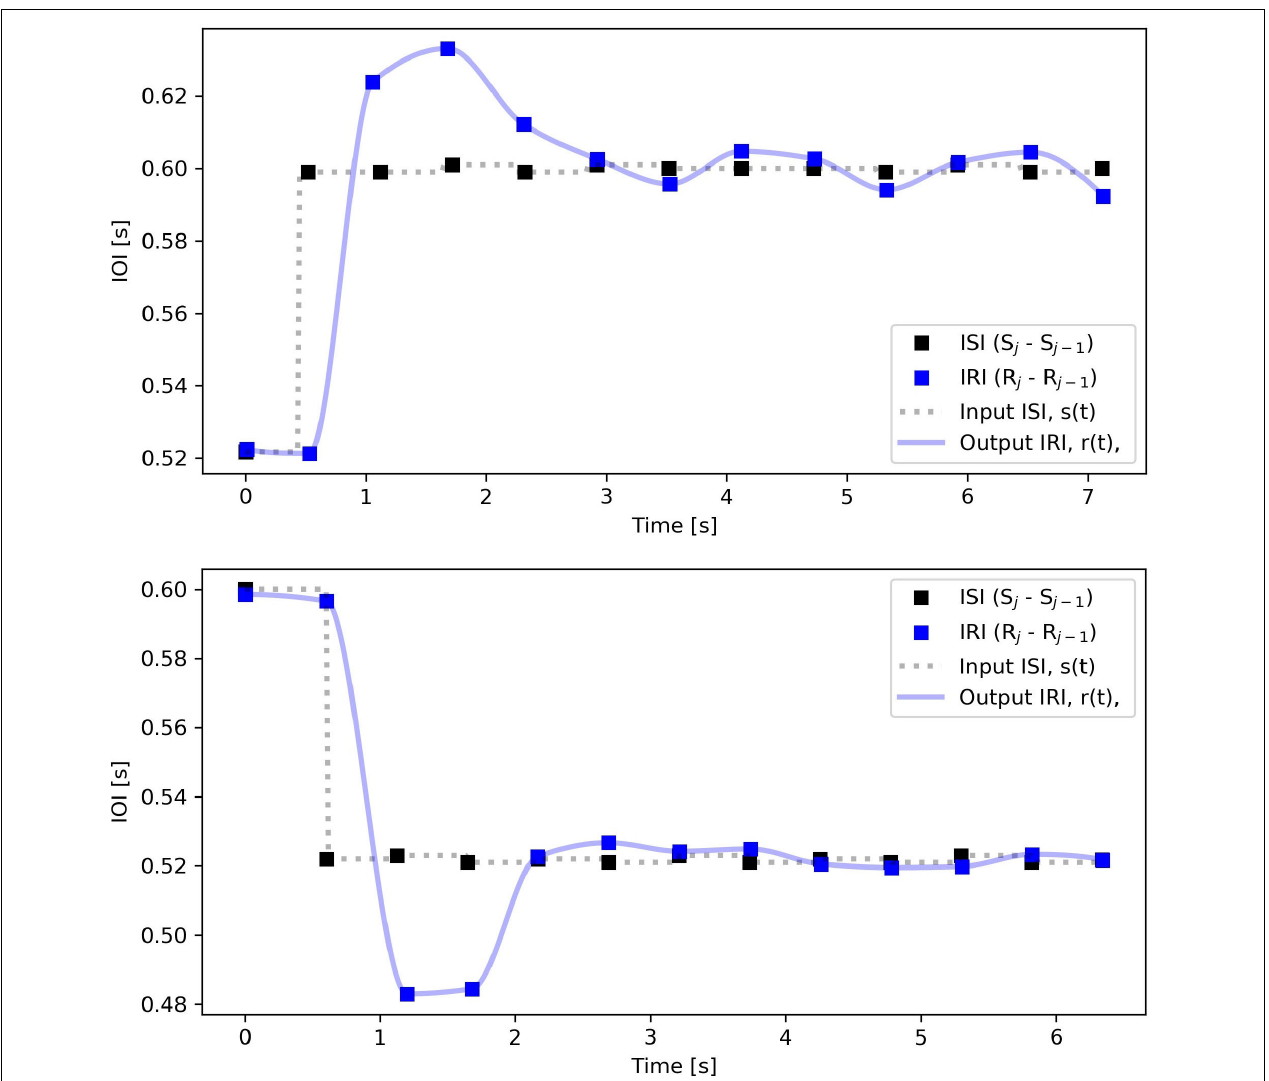
FIGURE 3 | Aggregated stimulus and response intervals over repetitions for the same subject/step size as Figure 2 and Table 1 . ISI, ˆ s j = ˆ S j − ˆ S j − 1 ( (cid:4) ), and IRI, ˆ r j = ˆ R j − ˆ R j − 1 ( (cid:4) ), are plotted as function of time instead of index number. The output r ( t ) is upsampled with the PCHIP algorithm and the input s ( t ) with staircase interpolation, both at 60 Hz sampling rate. Note that for the positive steps (increasing IOI, decreasing tempo) the arrival of the oversampled input step is marked slightly (This shift is only considered for positive steps where IOI increases. It is the same as the temporal distance between the solid line and the third dashed line in Figure 2 , which in seconds amounts to 60/endtempo(bpm) − 60/starttempo(bpm)) earlier than the arrival of the first onset of the new